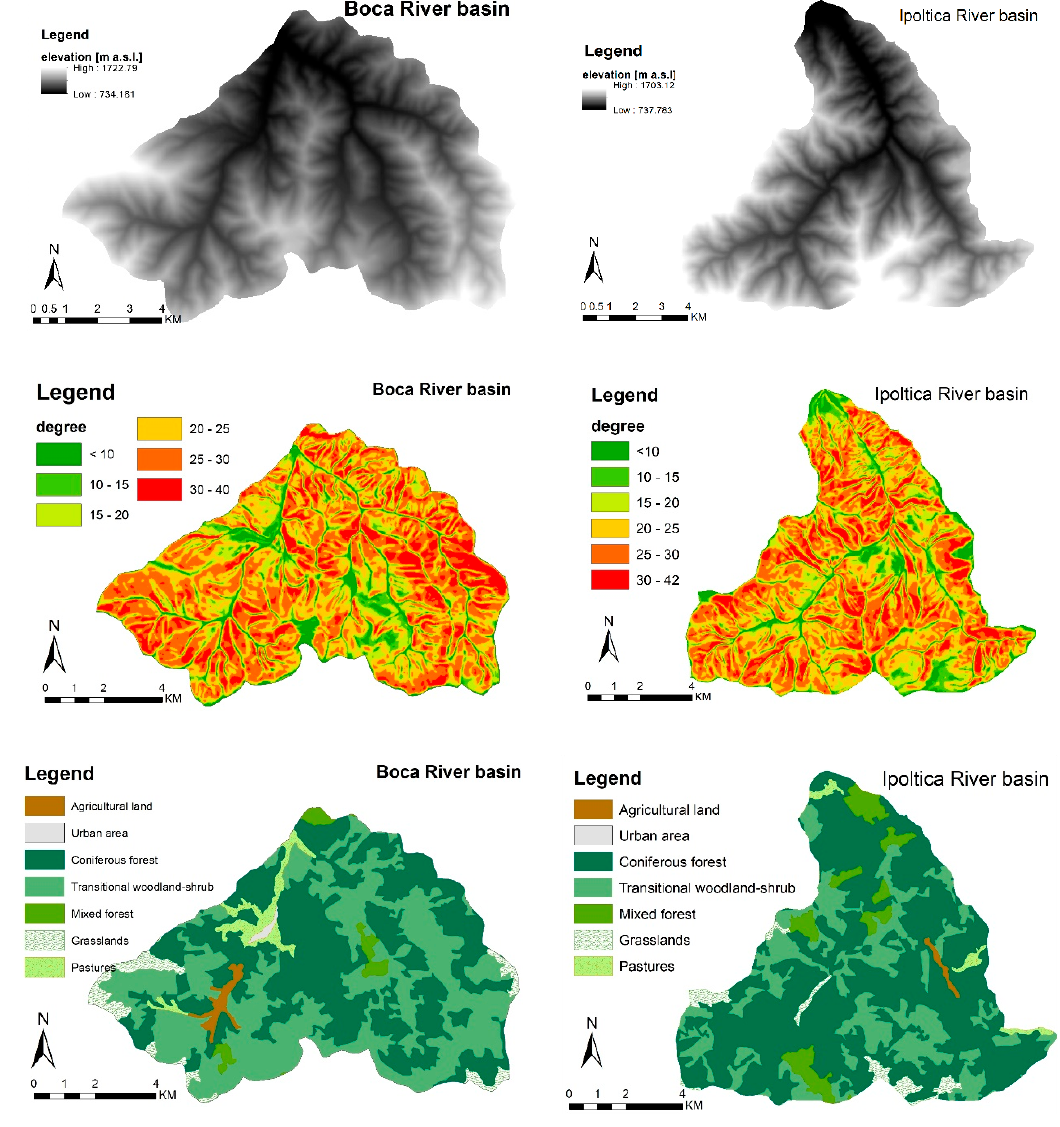
Figure 2. Elevation, slope map, and land cover classification for the Boca and Ipoltica River basins. In 1990, 82.76% of the area was covered by forests, but by 2018, this area had decreased to 46.8%. The deforested areas have mostly been replaced by transitional woodland